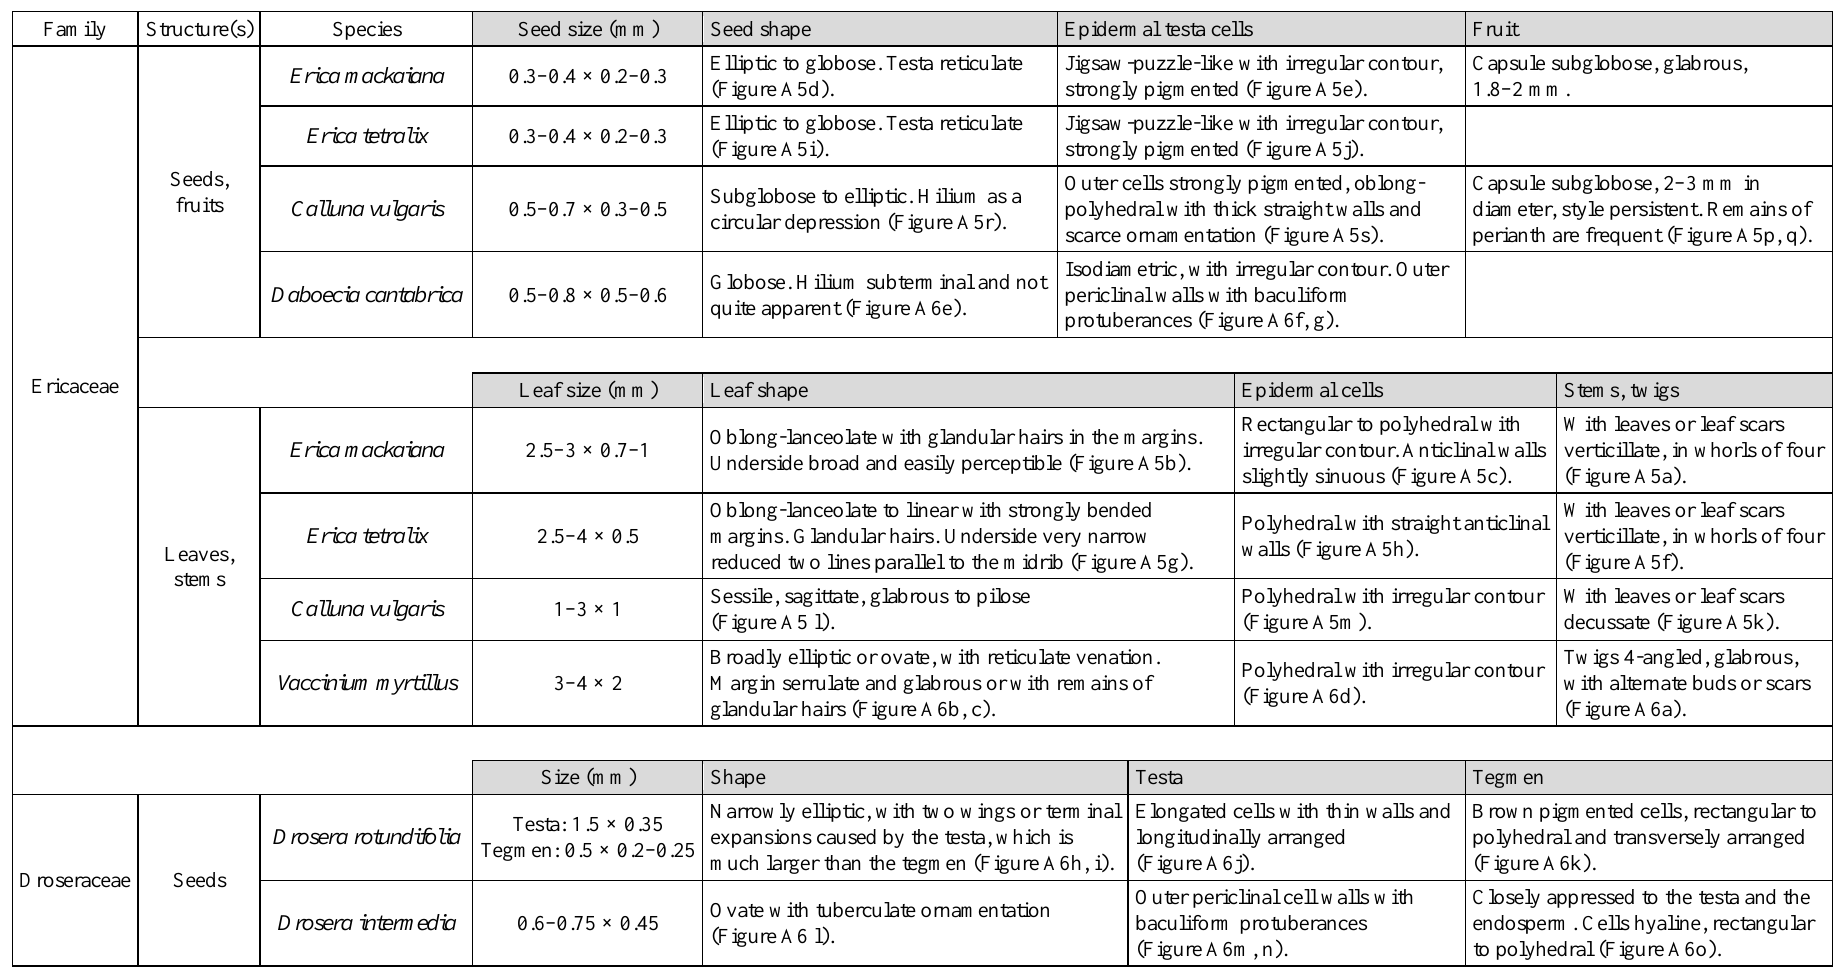
Table A3. Dicotyledons: Ericaceae and